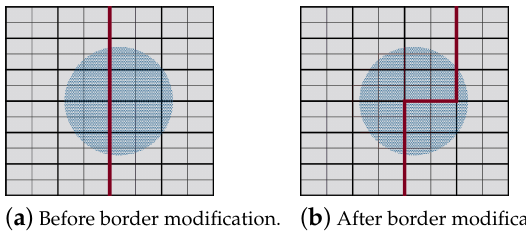
Figure 14. Border modification method sample.